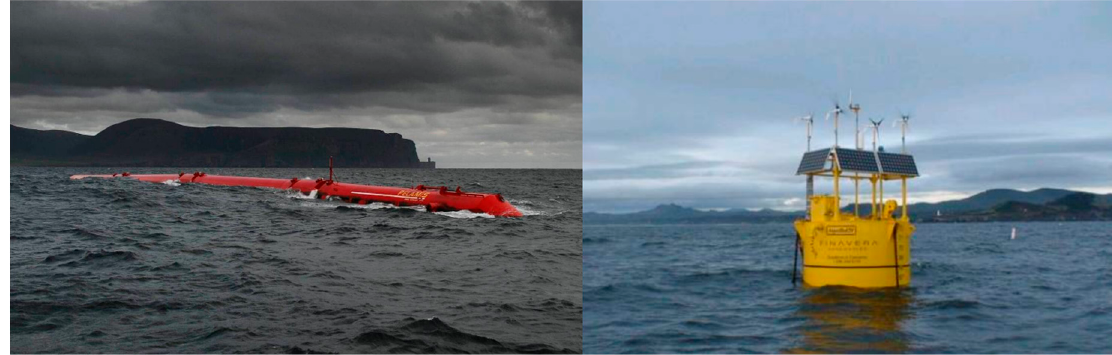
Figure 2. The two WECs considered in this study: Pelamis ( Left ) and Aqua Buoy ( Right ) [35]. Pelamis is an offshore device that has a length of 150 m and a tube diameter of 4.63 m; it consists